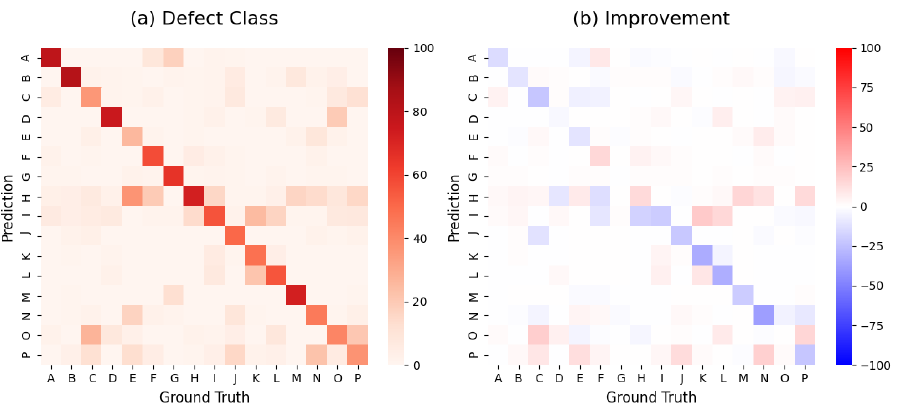
Figure 13. ( a ) Confusion matrix for the defect type task of the multi-branch model. ( b ) Accuracy improvement of the multi-branch model compared to the single-task model (defect type) from Figure 8. The model shows both a decrease and increase in accuracy for different classes. However, the overall performance of the task increased, as shown in Table